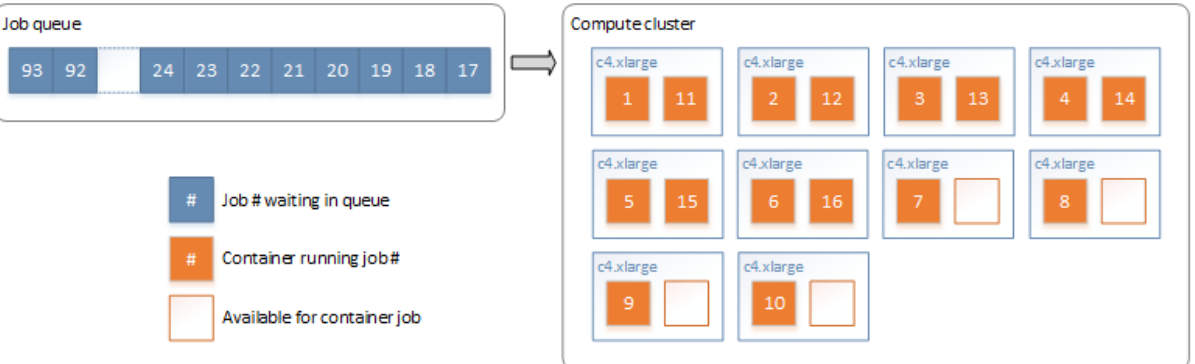
Figure 4. Matching jobs running on compute cluster (one job per bin).